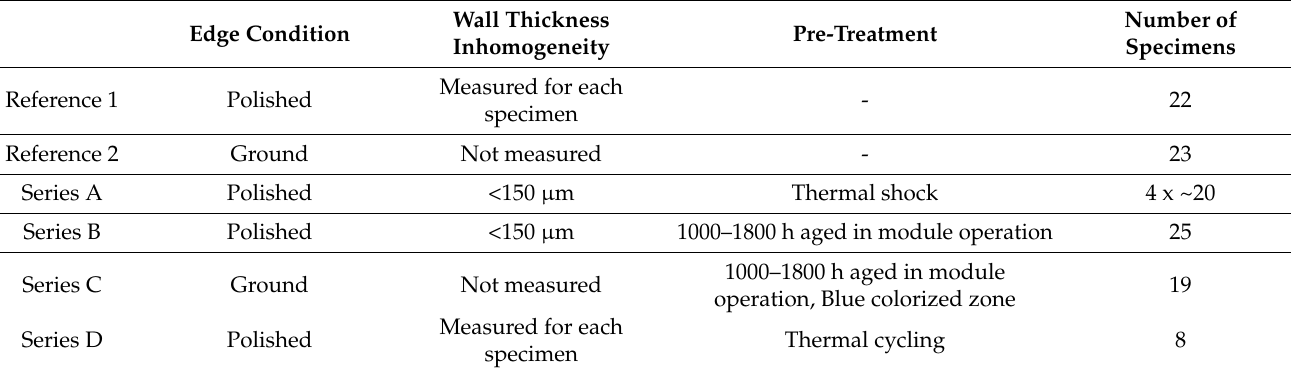
Table 1. Overview of tested brittle ring